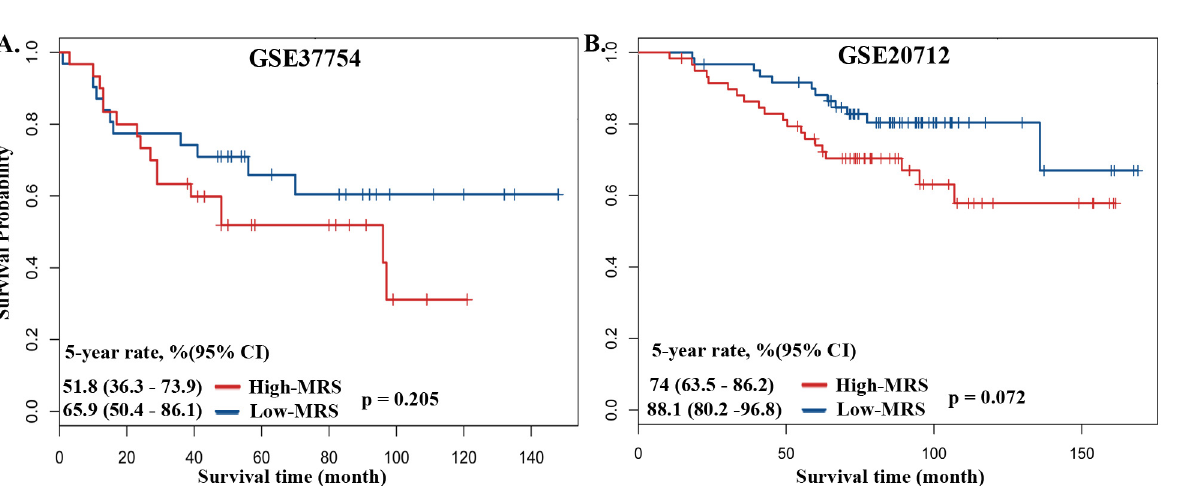
Fig 4. The Kaplan-Meier survival analysis of overall survival on four independent dataset from GEO database. (A) GSE37754 from 450K arrays. (B) GSE20712 from 27K arrays.